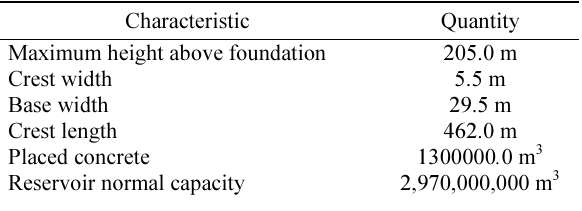
Table 1. Main characteristics of Karun III concrete arch dam